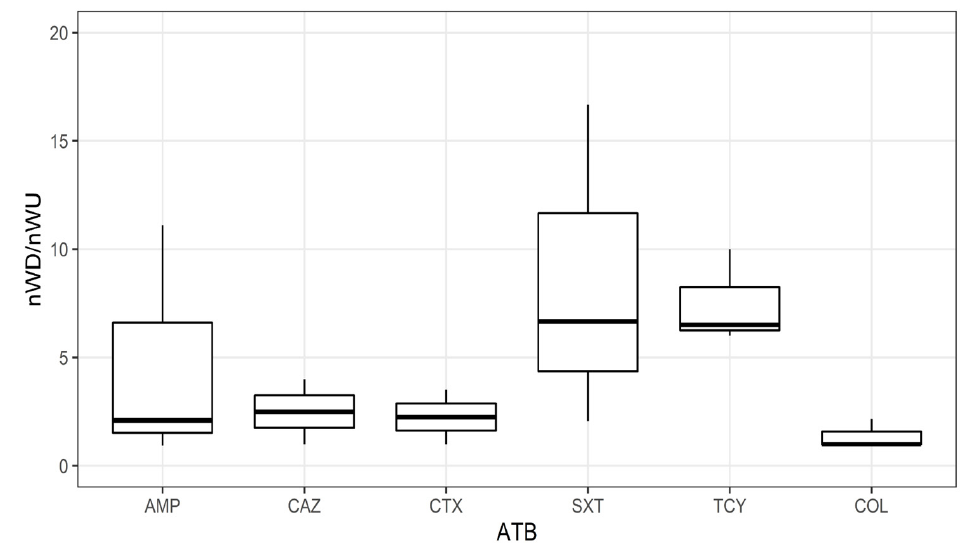
Figure 10. Downstream/upstream ratios (nWD/nWU) of the abundance of culturable Escherichia coli resistant to ampicillin (AMP), ceftazidime (CAZ), cefotaxime (CTX), sulfamethoxazole (SXT), tetracycline (TCY) and colistin (COL) measured in the river water.